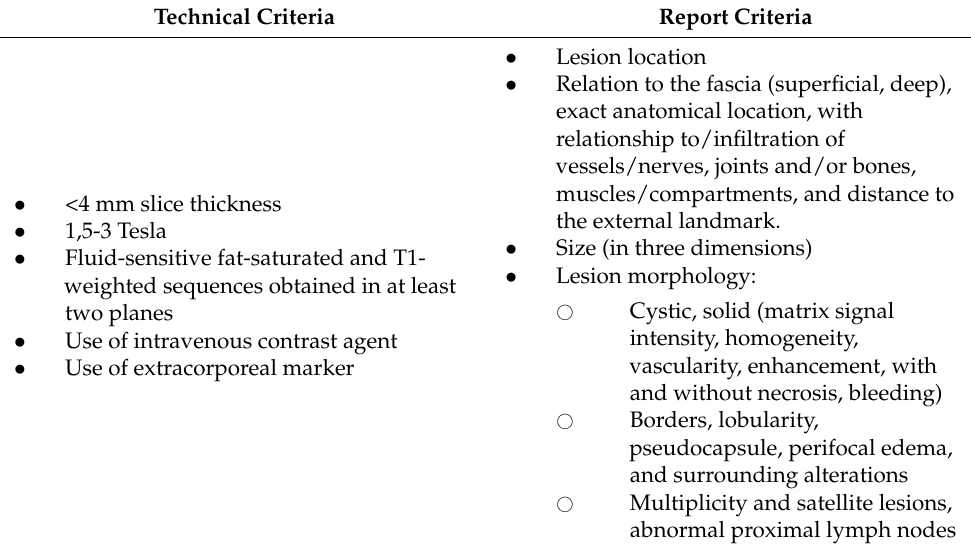
Table 1. Technical and content criteria according to the ESSR directive